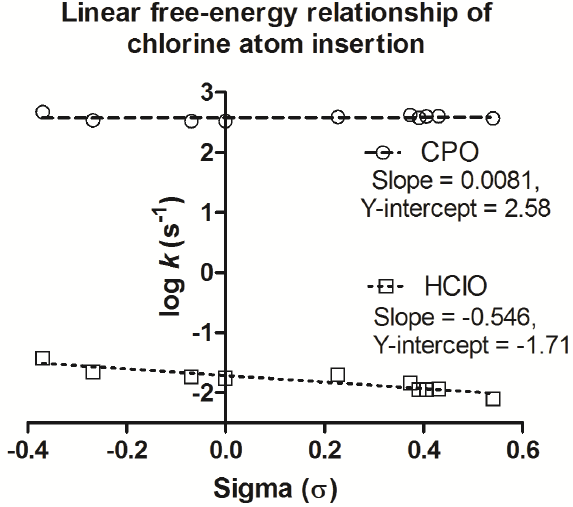
Figure 1: Hammett plots for CPO and hypochlorous acid (HClO) mediated chlorination of substituted styrenes at pH 2.75. The pseudo-first order rates of enzymatic chlorination was more than four orders higher than that of the HClO reaction and the enzyme catalyzed reaction did not show critical dependence on the electron density at the double bond. This was in stark contrast electrophilic substitution). Therefore, the two reactions